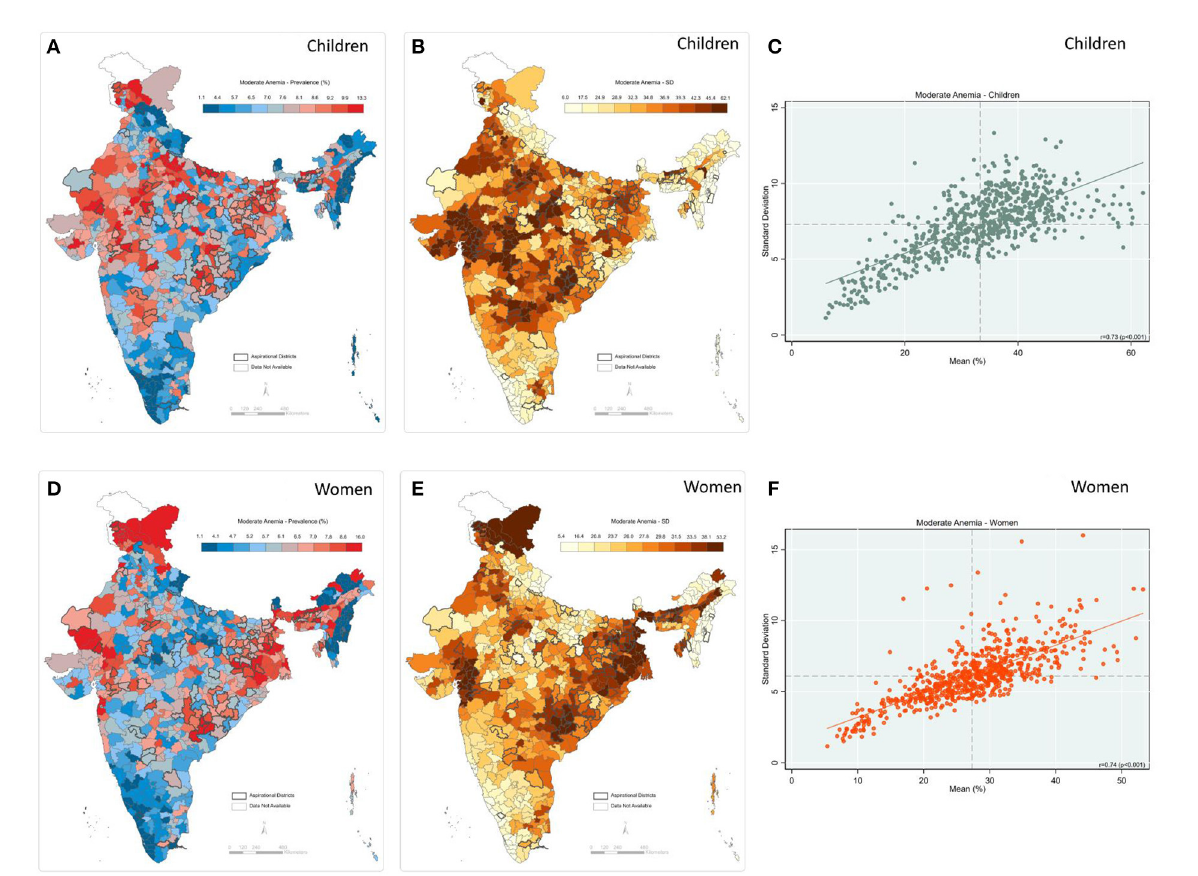
FIGURE6 Moderate anemia (A) Map-district-level prevalence among children; (B) Map-inter-cluster SD for children; (C) Scatter-prevalence vs. SD for children; (D) Map-district-level prevalence for women; (E) Map-inter-cluster SD for women; (F) Scatter-prevalence vs. SD for women, India, NFHS